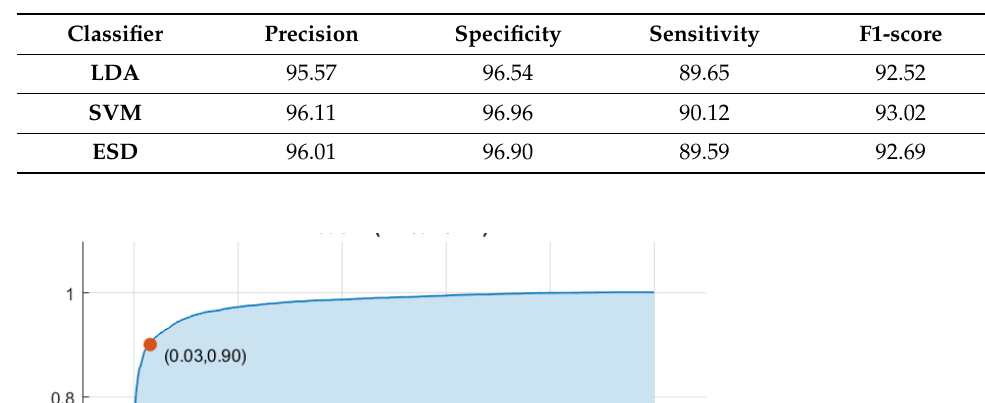
Table 2. The efficiency indicators (%) attained with the three GabROP classifiers using the 2000 DCT features.